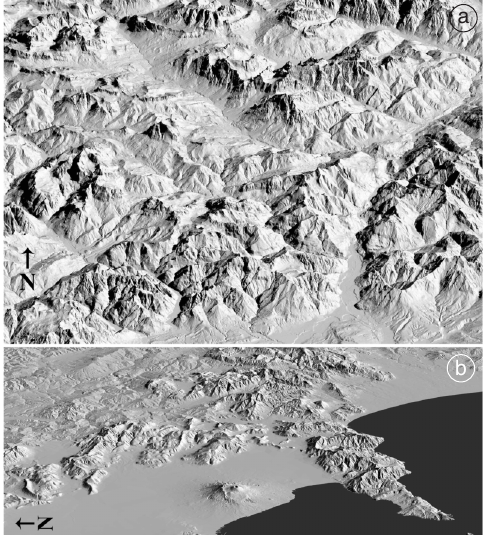
Fig. 11a,b. Perspective views derived from the TIN- ITALY/01 data base: a) the Dolomiti Mountains (Alps, NE Italy) and b) the area around Vesuvius Volcano (Campania Region). The approximate length of the foreground base of the perspective images are respec- tively 32 and 55 km.